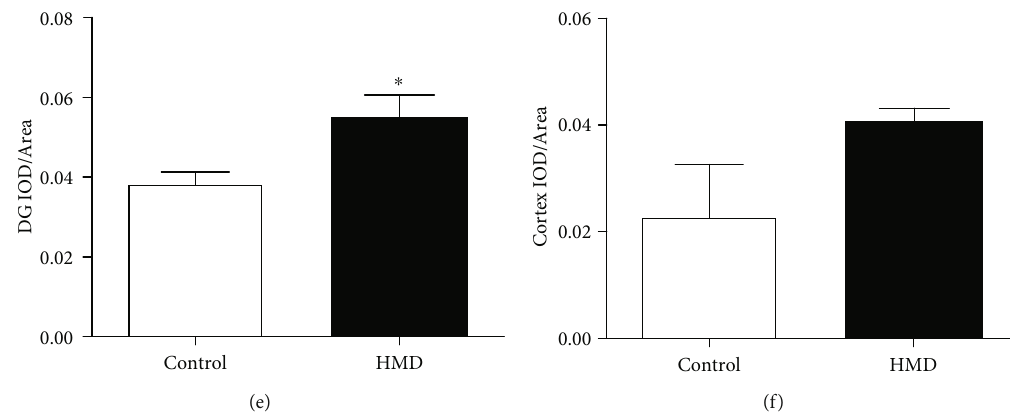
Figure 7: E ff ect of HMD on 5-mC IF staining of hippocampal and cortex tissues in mice. Sections of the hippocampus CA1, CA3, DG region, and cortex were obtained and stained with IF (magni fi cation, 400x). (a) Showed representative photomicrographs of 5-mC IF staining results of each group in hippocampal CA3 region. (b) Showed representative photomicrographs of 5-mC IF staining results of each group in hippocampal DG region. (c) Showed the CA1 IOD/area of each group. (d) Showed the CA3 IOD/area of each group. (e) Showed the DG IOD/area of each group. (f) Showed the cortex IOD/area of each group. Note: value was expressed as mean ± SEM ( n = 4 ). ∗ p < 0 : 05 vs. control group.